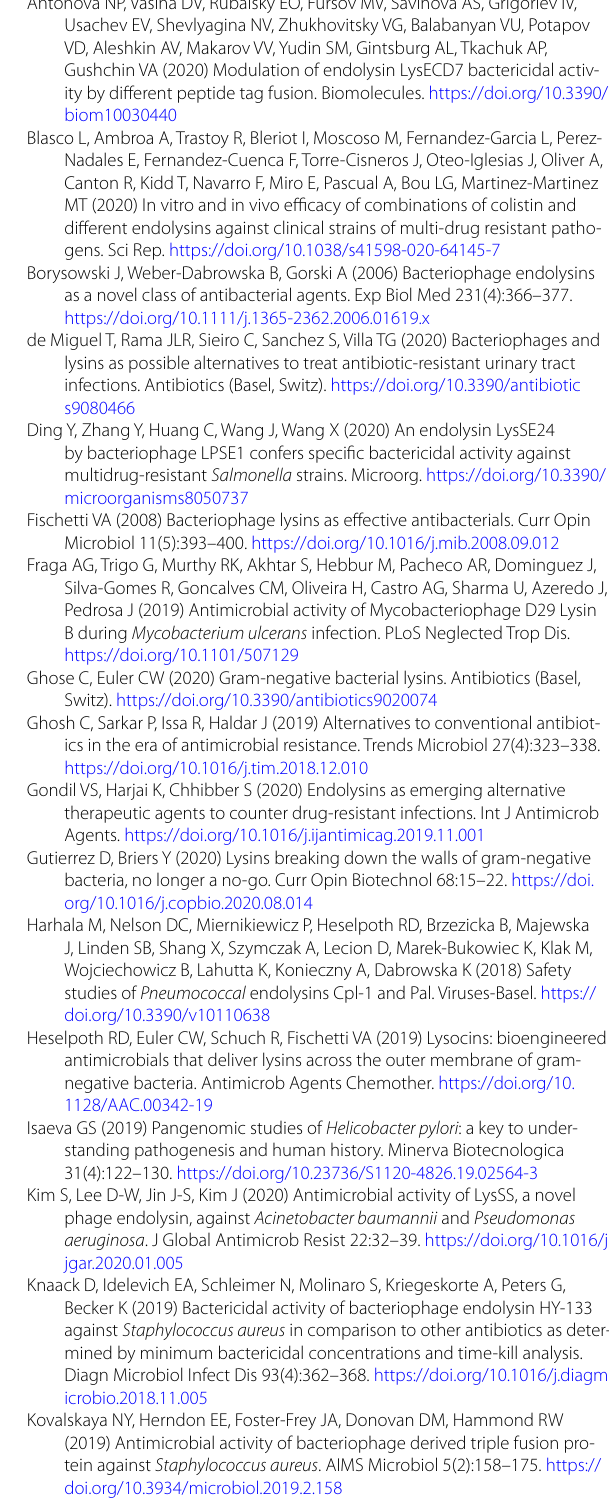
Table S3. High-density fermentation data record